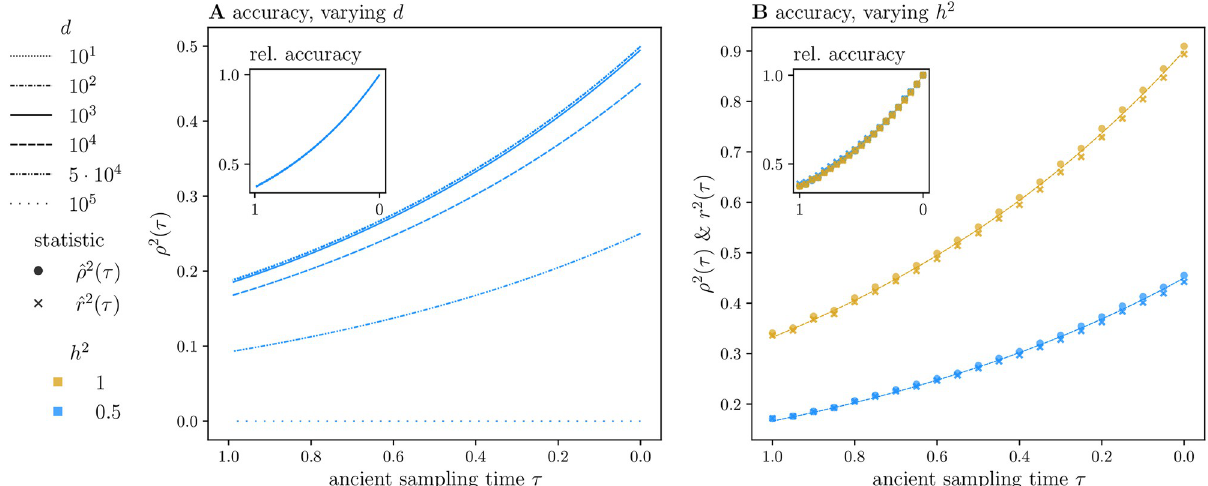
Fig 3. Polygenic score accuracy. We plot our theoretical results for both absolute (A, main) and relative accuracy ρ 2 ( τ ) (A, inset) for ancient sampling times τ 2 [1, 0] (or a time span of 2 N generations) with a mutation rate of a = 10 − 3 . The GWA study size is shared in all plots, with n = 10 5 . In (A), we vary the detection threshold over the range of possible values, d 2 {10, ... 10 5 }. In (B), we compare our theoretical expectations with simulated ℓ estimates of the approximate sample correlation coefficient ρ 2 ( τ ) (circles) and the statistic itself r 2 ( τ ) (crosses) for a threshold of d = 10 4 (a minimum sample allele frequency of 0.05), and two values of heritability, h 2 = 0.5, 1 (in blue and gold, respectively). The ancient sample size is n = 100. In the a inset of (B), we normalize the estimates by their initial (estimated) values. Theoretical expressions for ρ 2 ( τ ) are also plotted in (B). Each simulated point is the average of K = 5000 simulations of L = 5000 iid